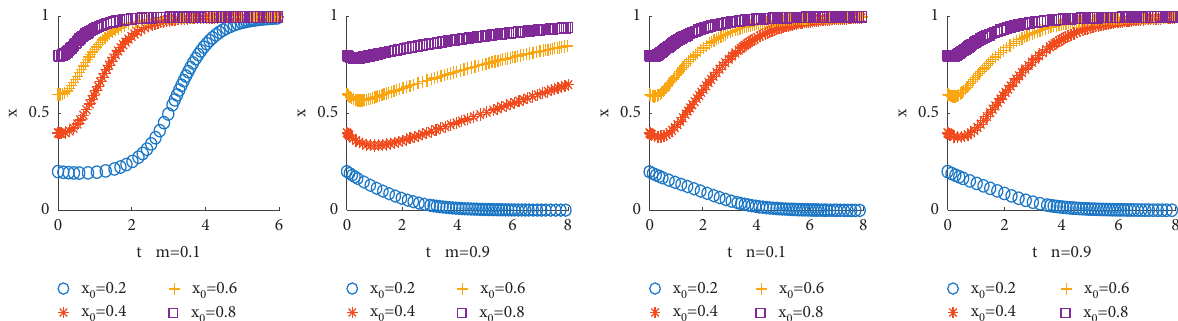
Figure 7: The impact of revenue spillover coefficient on evolution system.